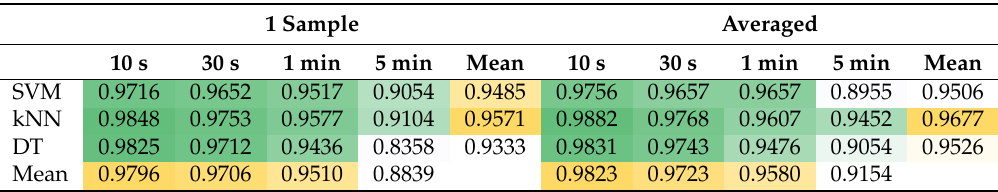
Table 8. Resolution selection results for the living room location. Individual scores are shown in green and mean scores in yellow. A stronger color indicates a higher